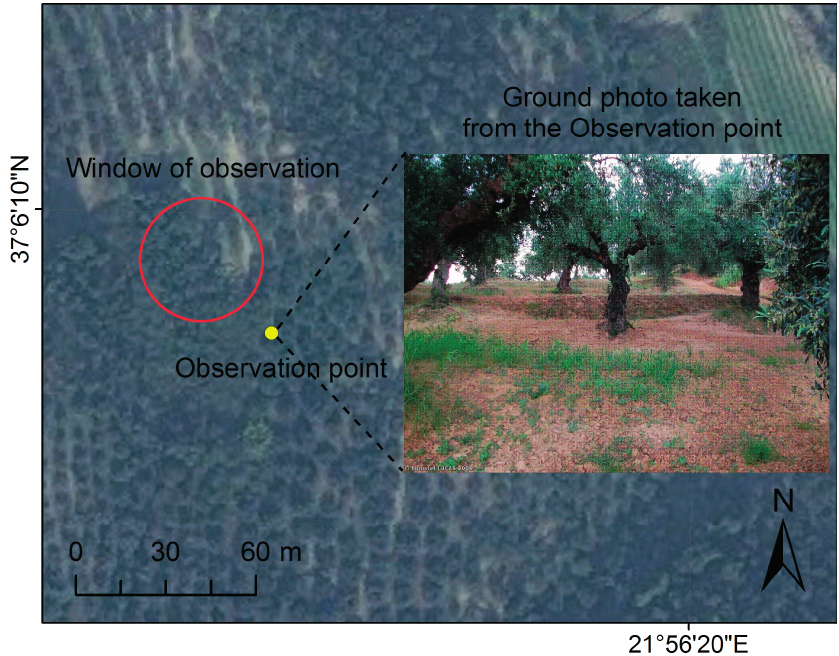
Figure 10. A particular case in Messinia, where the point to be assessed is found in a transitional zone between olive trees and high shrub patches. The point was classified as agricultural land by WWF Hellas and as “Shrubland with sparse tree cover” (D10) by the LUCAS surveyors; in the inset: an eastward photograph taken by the surveyors. During reinterpretation of ground photos taken in points classified as “Agricultural land” (2), several cases were discovered, where the assessment conducted by LUCAS surveyors could be considered